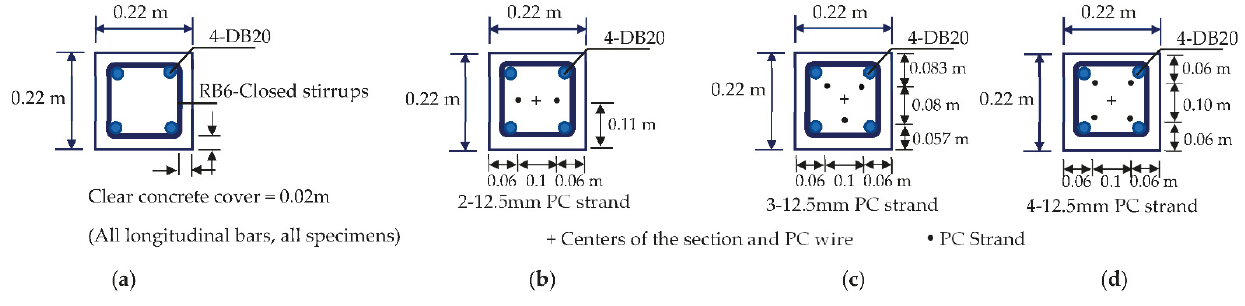
Figure 2. Cross-section and location of prestressing wires (not scaled): ( a ) 0.00 A g f c (cid:48) ; ( b ) 0.14 A g f c (cid:48) ; ( c ) 0.21 A g f c (cid:48) ; ( d ) 0.28 A g f c (cid:48)